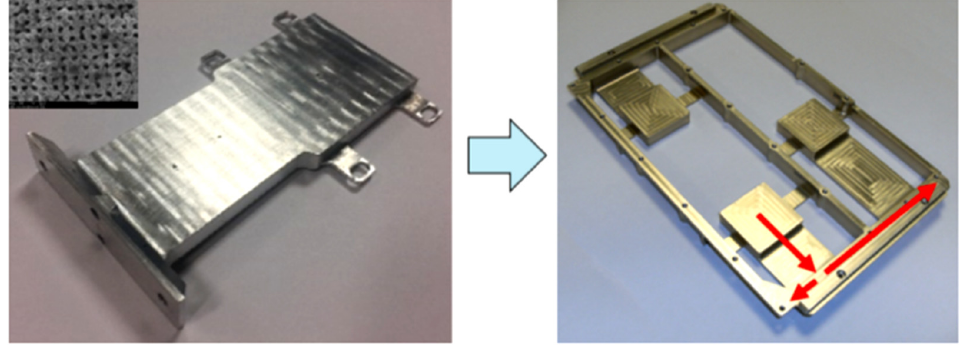
Figure 16. Integration of AM vapour chamber HP into the electronic unit body [17].